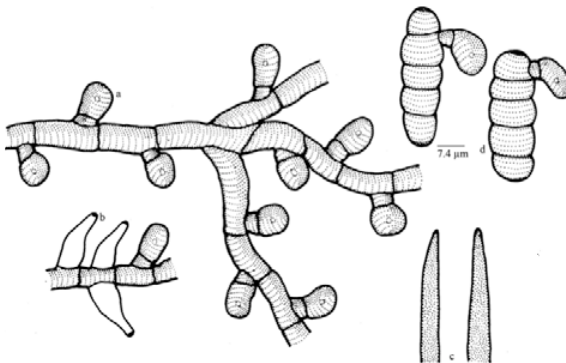
Figure 46. Meliola aristolochigena a - Appressorium; b - Phialide; c - Apical portion of mycelial setae; d -